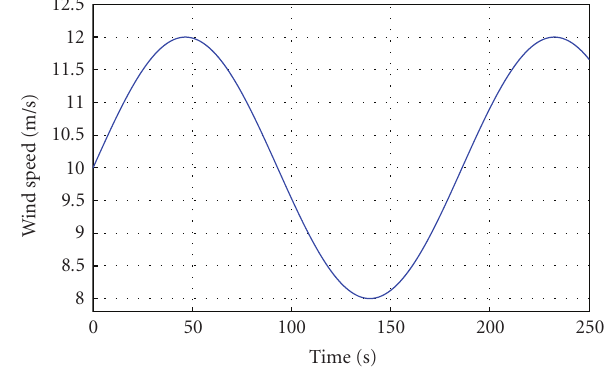
Figure 8: Per unit wind turbine produced power.